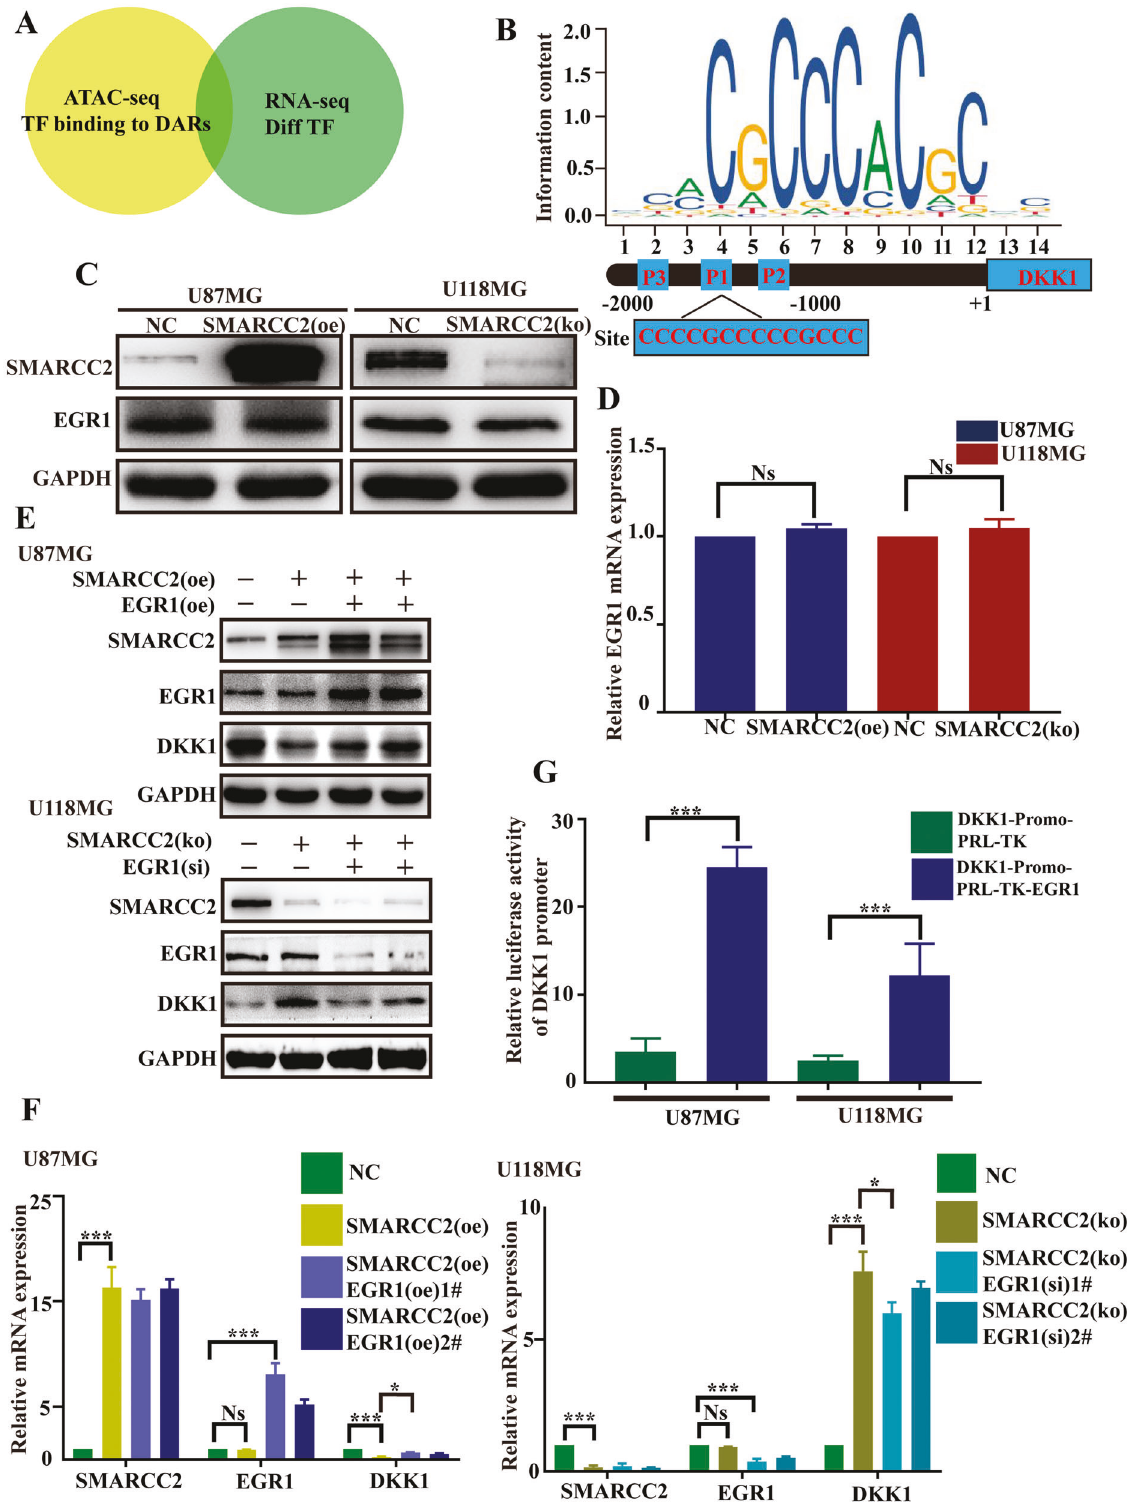
Fig. 4 Bioinformatics screening of transcription factors potentially regulating the DKK1 promoter in glioma. A Combine ATAC-seq data and RNA-seq data to screen for possible transcription factors. B JASPAR motif logo of the predicted TF EGR1. C The protein level of EGR1 was unchanged after the change of SMARCC2 using a western blot. D The mRNA level of EGR1 was unchanged after the change of SMARCC2 using qRT – PCR. E Western blot was used to detect the protein levels of SMARCC2, DKK1, and EGR1 after Simultaneously alter the expression levels of SMARCC2 and EGR1 in glioma cells. Columns 3 and 4 show two independent replicates. F qRT – PCR was used to detect the mRNA levels of SMARCC2, DKK1, and EGR1 after change of SMARCC2 and EGR1 in glioma cells. 1# and 2# represent two independent replicate experiments. G Upregulation of EGR1promoted luciferase activity of luc-DKK1 in U87MG and U118MG cells. *** P < 0.001, compared with NC. Data are expressed as mean ± SEM. ns not signi fi cant, * P < 0.05, ** P < 0.01, *** P < 0.001. Cell Death and Disease